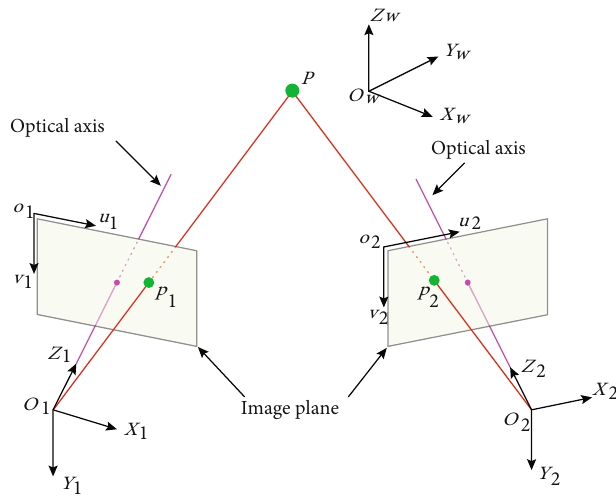
Figure 7: Principle of binocular stereophotogrammetry.